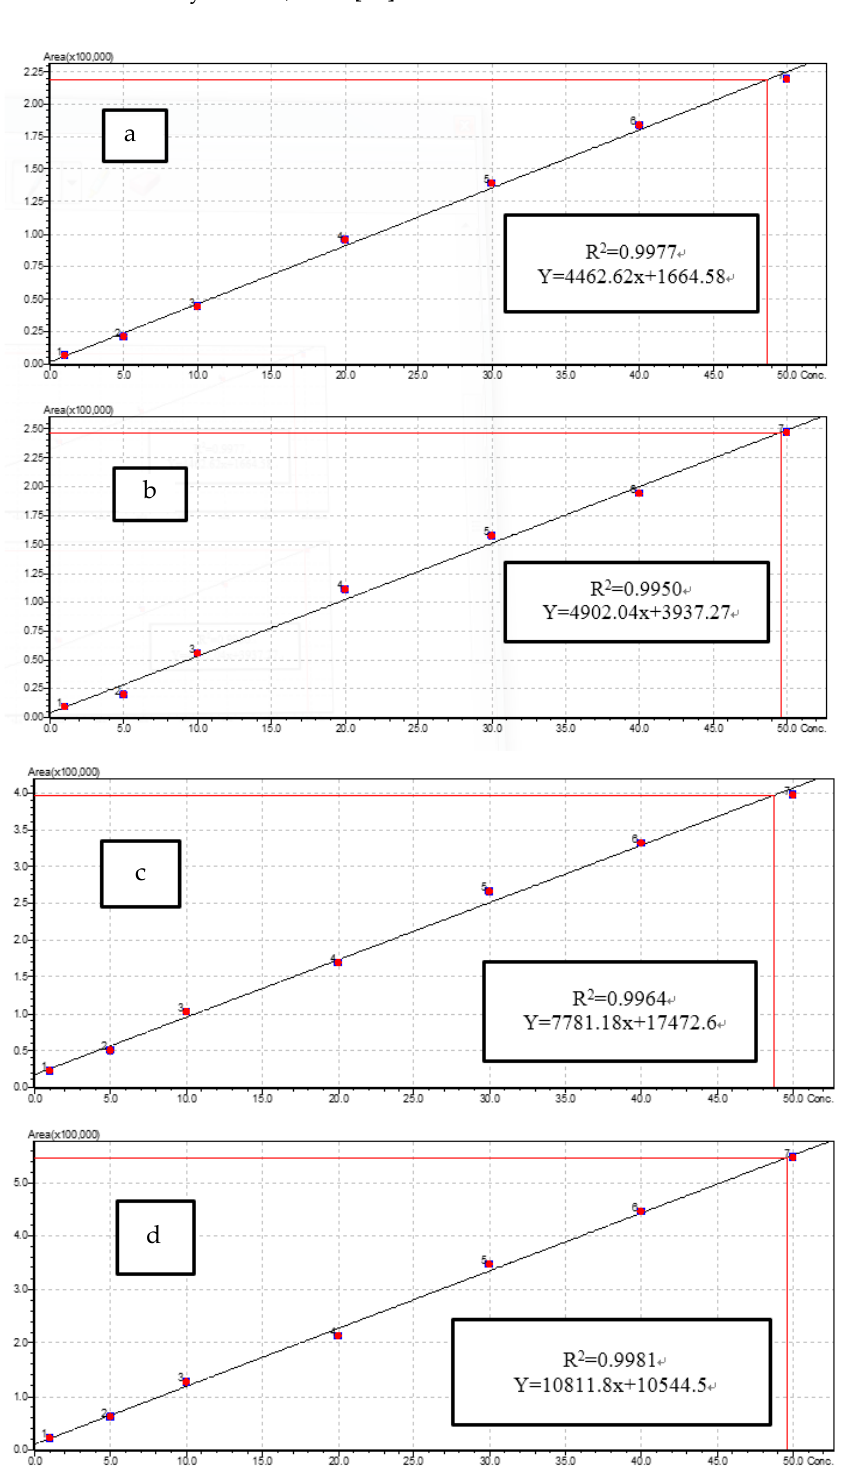
Figure1. Calibrationcurvesfor( a )oxytetracycline, ( b )tetracycline, ( c )ampicillinand( d )sulfamethazine Figure 1. Calibration curves for ( a ) oxytetracycline, ( b ) tetracycline, ( c ) ampicillin and ( d ) 1, 5, 10, 20, 30, 40 and 50 µ g / sulfamethazine 1, 5, 10, 20, 30, 40 and 50 µg/L.